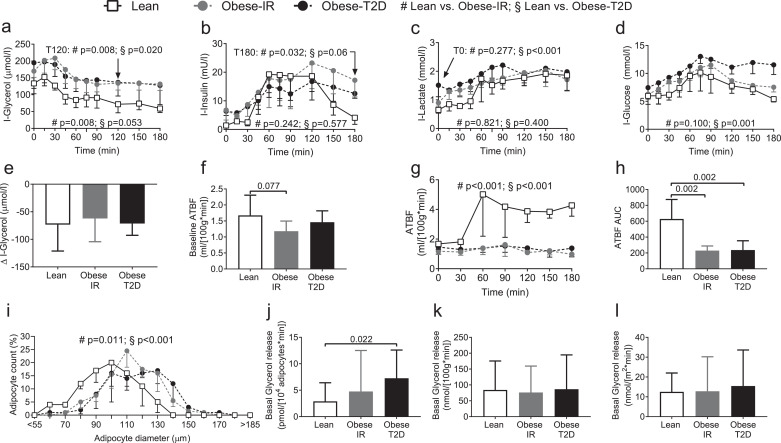
Measurements of abdominal subcutaneous adipose tissue function in Lean, Obese-IR, and Obese-T2D subjects.During the OGTT in Fig. 2 we collected dialysates of abdominal subcutaneous adipose tissue and measured the concentrations of: (a) Interstitial glycerol (I-Glycerol); (b) interstitial insulin (I-Insulin); (c) interstitial lactate (I-Lactate); and (d) interstitial glucose (I-Glucose). (e) Maximum decrease in I-Glycerol from the baseline value during the OGTT. (f) Basal subcutaneous adipose tissue blood flow (ATBF) measured by 133Xe-clearance technique. (g) ATBF during the OGTT; and (h) ATBF area under the curve (AUC) of g.Data are presented as median and error bars indicate interquartile range (IQR) for each group. (i) Adipocyte size distribution curves of abdominal subcutaneous adipose tissue biopsies from Lean; Obese-IR; and Obese-T2D volunteers. Basal glycerol release rates from abdominal subcutaneous adipose tissue were calculated per: (j) 104 adipocytes; (k) 100 g of adipose tissue; and (l) adipocyte surface area. (a, c-e) n = 9 for Lean, n = 8 for Obese-IR and n = 9 for Obese-T2D. (b) n = 9 for Lean, Obese-IR and Obese-T2D. (f-i) n = 9 in Lean and Obese-IR, and n = 8 in Obese-T2D. (j-l) n = 9 for lean, n = 8 for obese-IR and n=8 for obese-T2D. [Mann-Whitney U-test for all bars and specific time points in curves a-c (mixed-effects models available in Supplementary Table 3), mixed-effects models for all time dependent curves (a-d, g). Mann-Whitney U-test for participant average cell size in (i)].